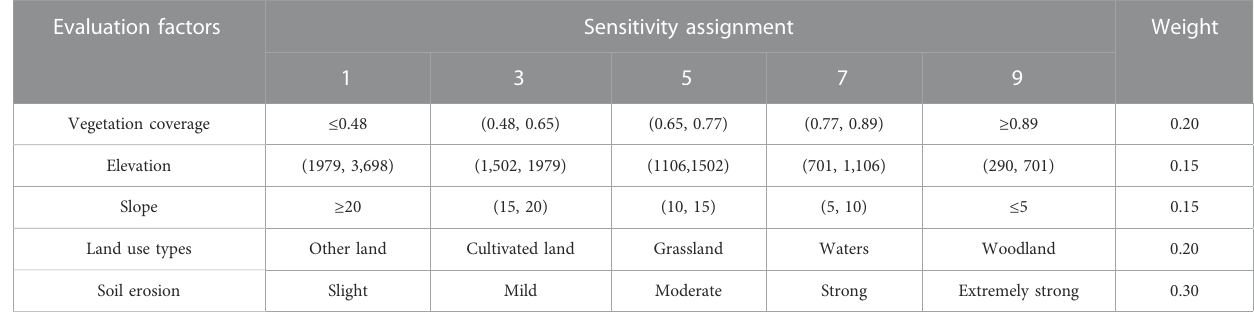
TABLE 2 Classi fi cation and weight of ecological sensitivity evaluation